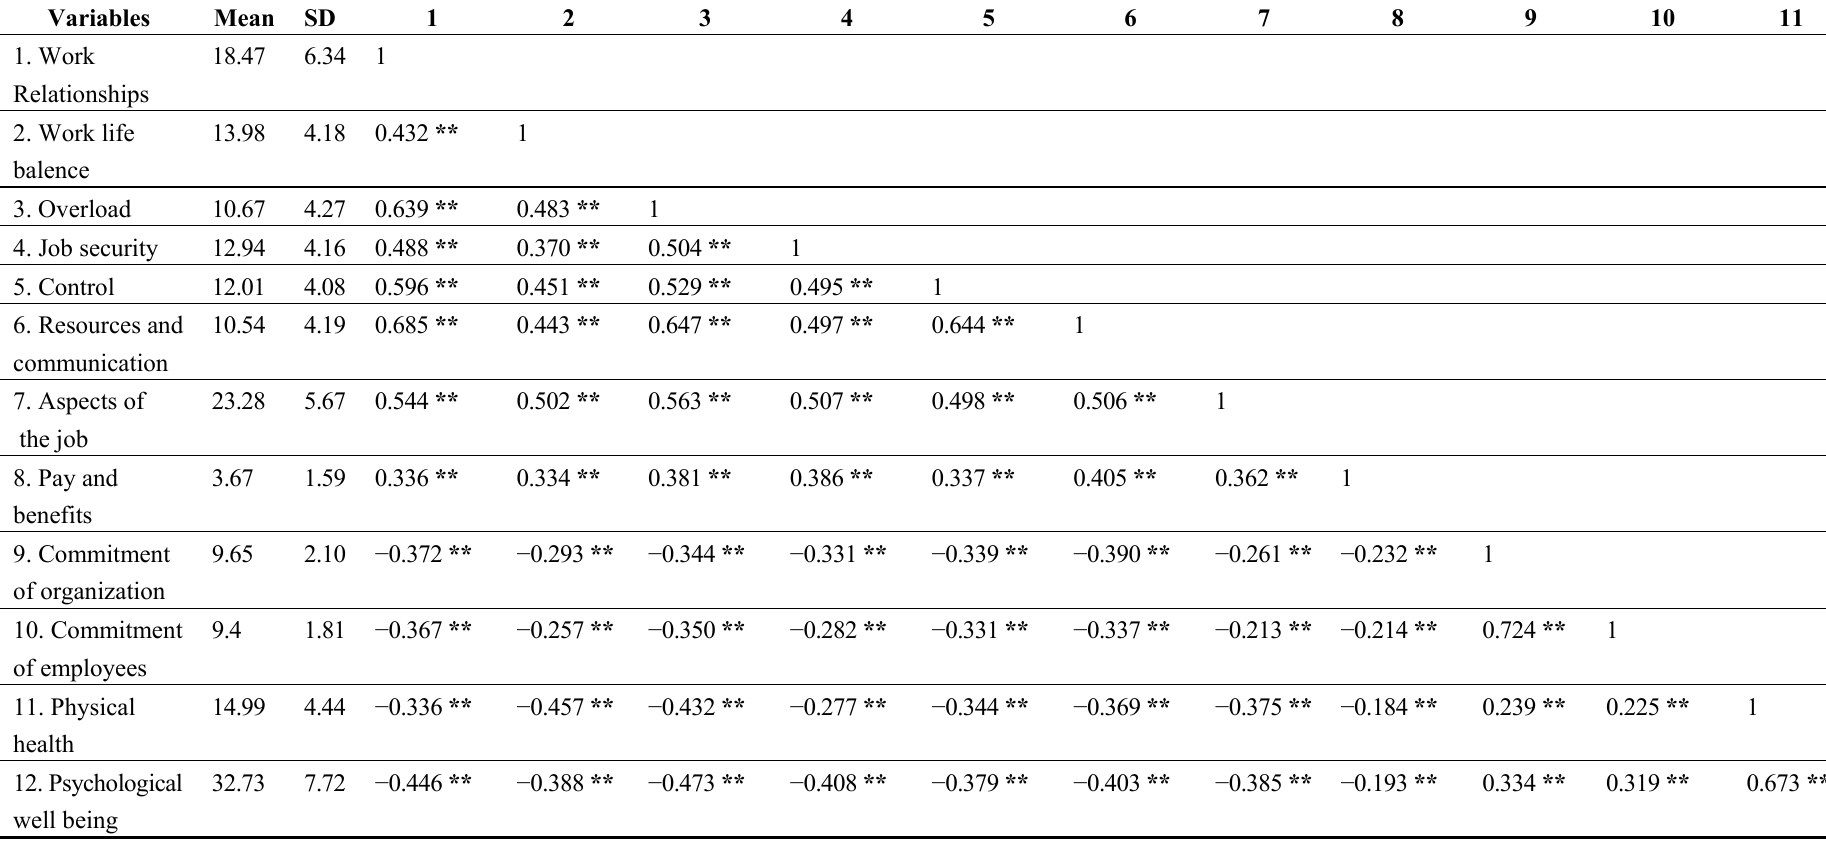
Table 3. Means, standard deviations and correlations for all the variables in this study. Note: ** Correlation is significant at the 0.01 level.